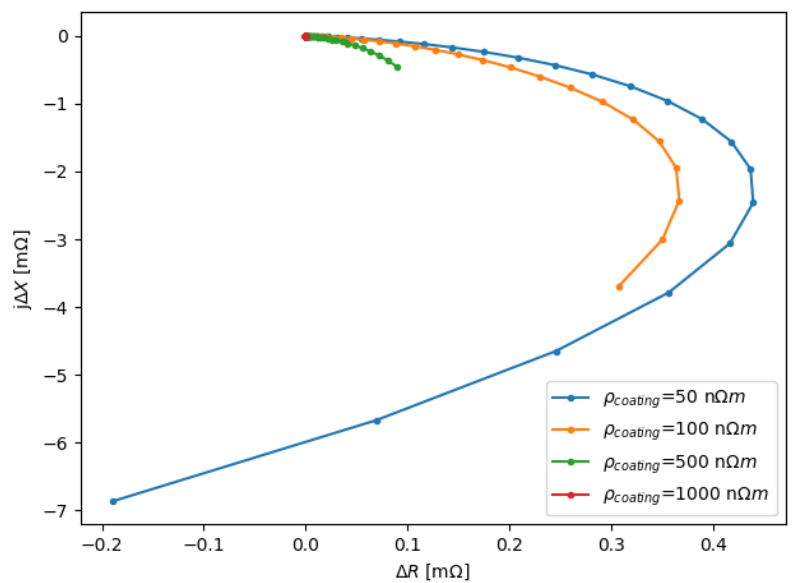
Figure 14. Simulated coil response for variable coating resistivity as a function of frequency. We assume a bulk of 1.5 mm thickness, with a resistivity of 1000 n Ω m, and a coating of 6 µ m thickness. The lift-off is 0.7 mm.